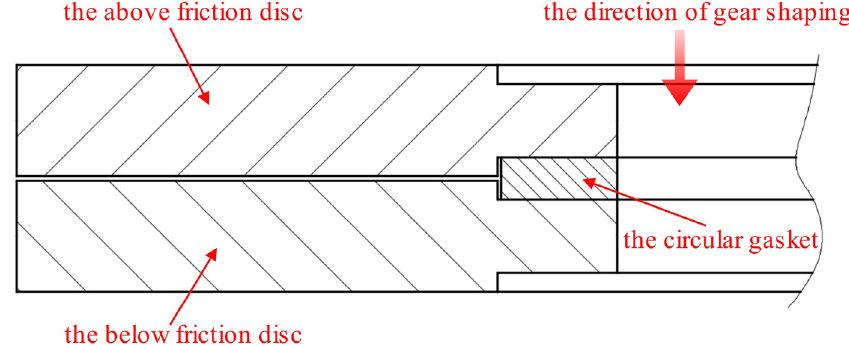
Figure 10: The position of the circular gasket in the gear - shaping process.